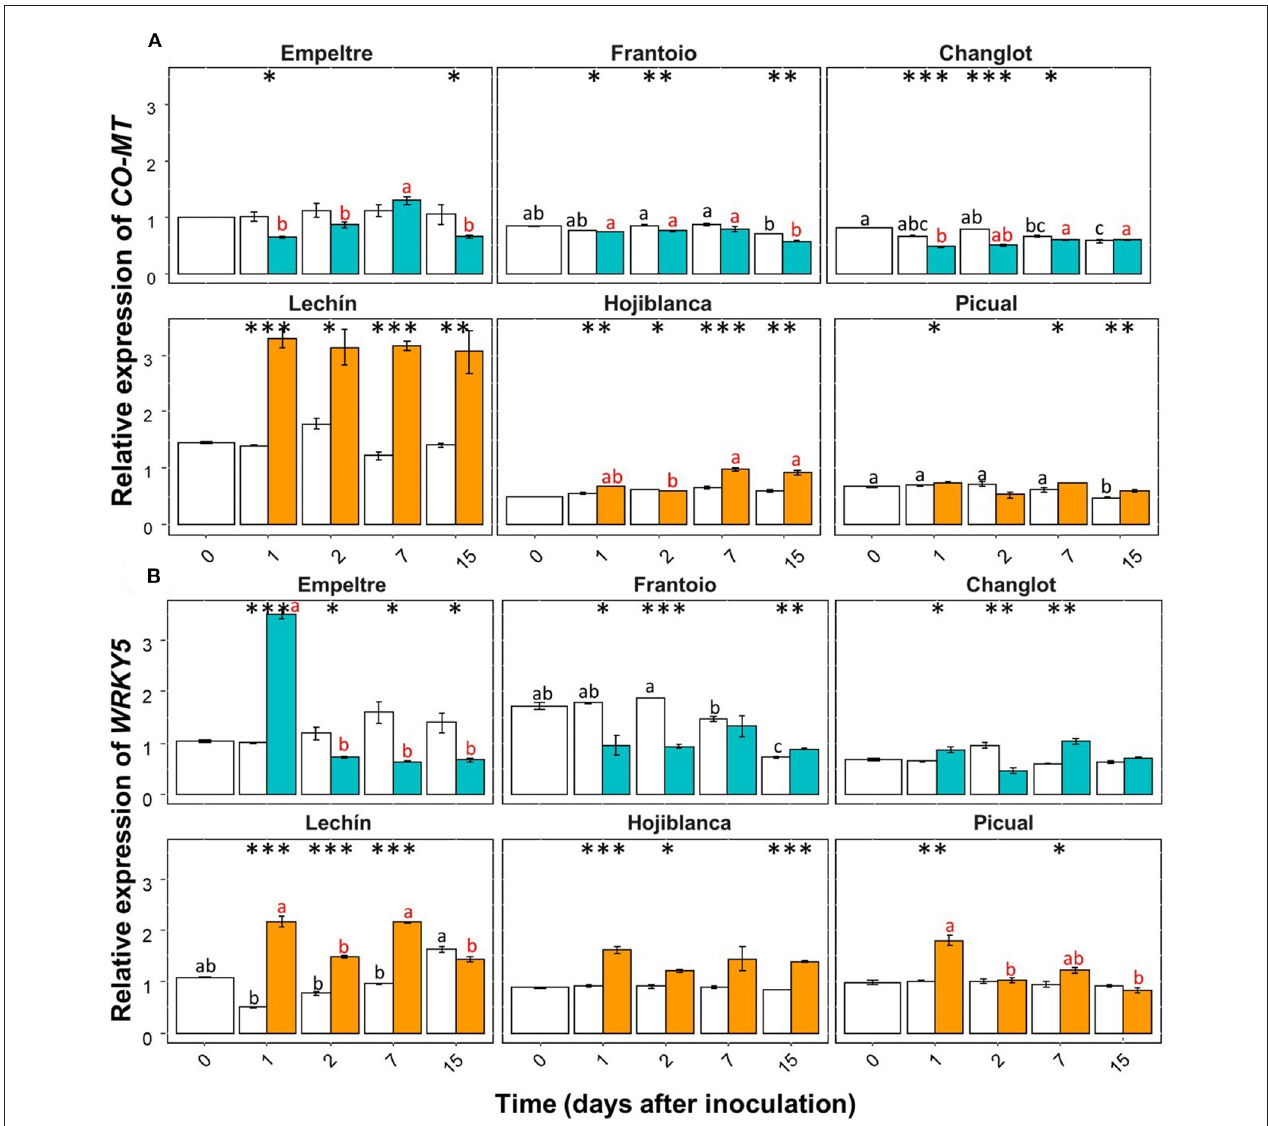
FIGURE 6 | Time course of the relative expression of the CO-MT (A) and WRKY5 (B) genes. Control (non-inoculated) plants are represented in white color while Verticillium dahliae -inoculated plants are shown in light blue color (tolerant cultivars) or in orange color (susceptible varieties). The error bar corresponds to the standard deviation (SD) from the mean of the three biological replicates. Tukey’s post hoc test differences ( p < 0.05) are represented with black letters among the control plants and in red letters among the inoculated plants. The statistical differences resulted by the ANOVA analysis between the control and inoculated plants are represented by asterisks (level of significance: *, p < 0.05; **, p < 0.01; ***, p <